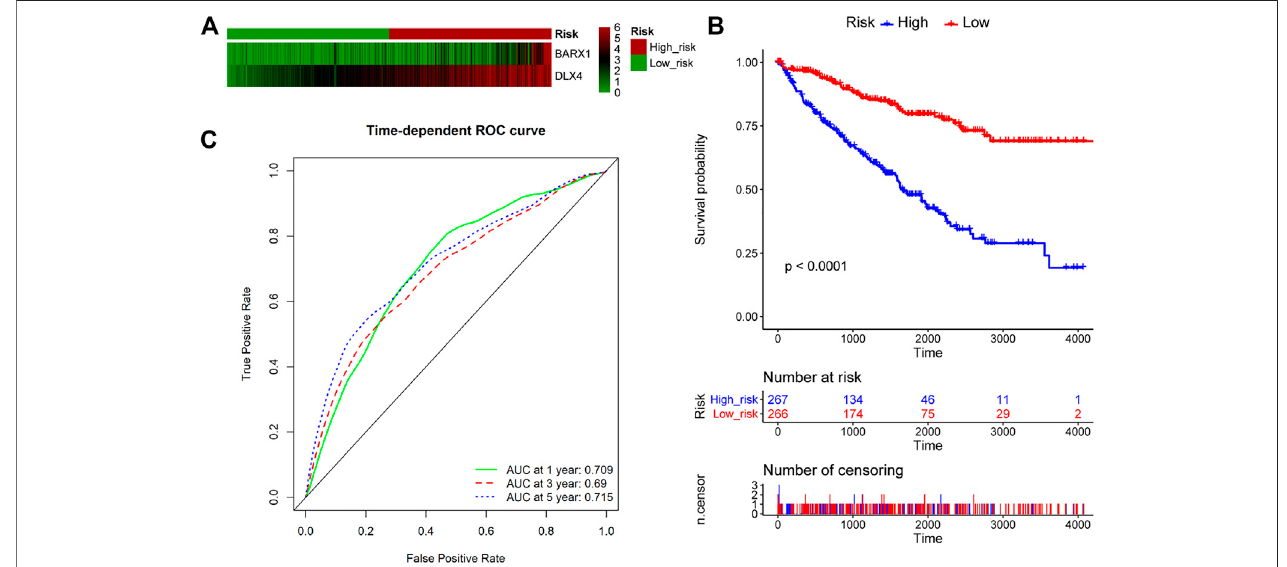
FIGURE 8 | BARX1 and DLX4 combination as a prognostic model for OS in ccRCC. (A) Patients in the TCGA KIRC cohort were divided into high-risk group and low-risk group. The expression pro fi le ofBARX1 and DLX4 inhigh-riskand low-risk patients, respectively. (B) The Kaplan – Meier plotshows the OSin high-risk and low- risk patients in the TCGA KIRC cohort. (C) The time-dependent AUROC curve is plotted to evaluate the prognostic value of BARX1 and DLX4 prognostic signature for OS. The AUC at one, three, and fi ve years is 0.709, 0.690, and 0.715, respectively.